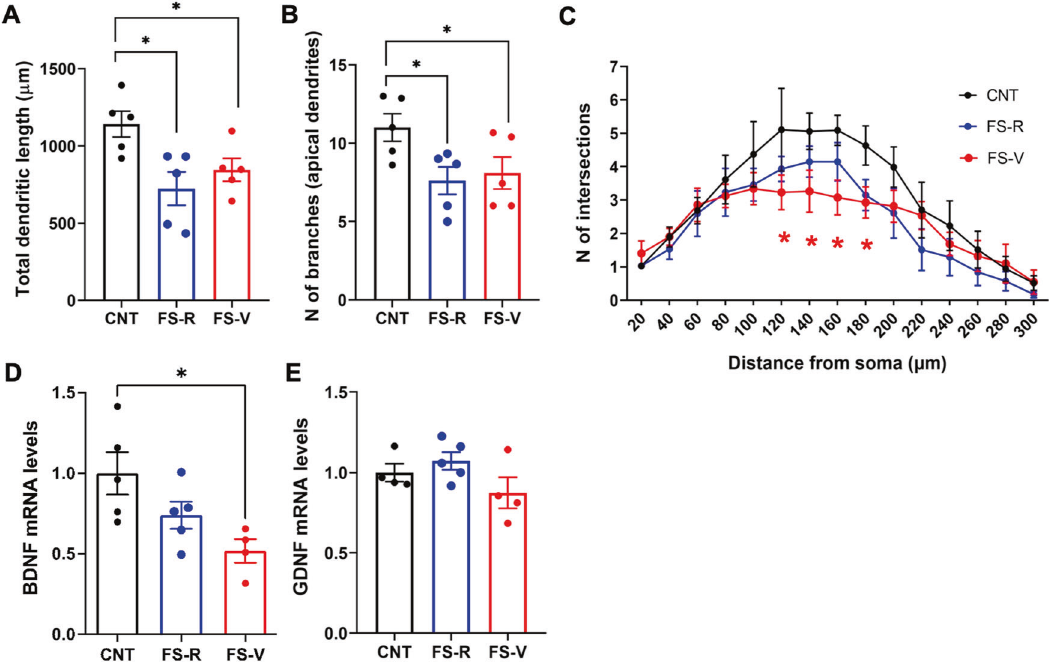
Fig. 4 Dendritic arborization and neurotrophin expression in PFC. A Total length of PFC layers II – III pyramidal neurons apical dendrites. One-way ANOVA, Holm- Š ídák post-hoc test: * p < 0.05. B Number of branches. One-way ANOVA, Holm- Š ídák post-hoc test: * p < 0.05. C Sholl analysis. Mixed-effects model, Dunnett ’ s post-hoc test: * p < 0.05; N = 5 (CNT), 5 (FS-R), 5 (FS-V), 3 – 6 pyramidal neurons/animal. D BDNF and ( E ) GDNF mRNA expression levels in PFC. Kruskal-Wallis test, Dunn ’ s post-hoc test: * p < 0.05; N = 5 (CNT), 5 (FS-R), 5